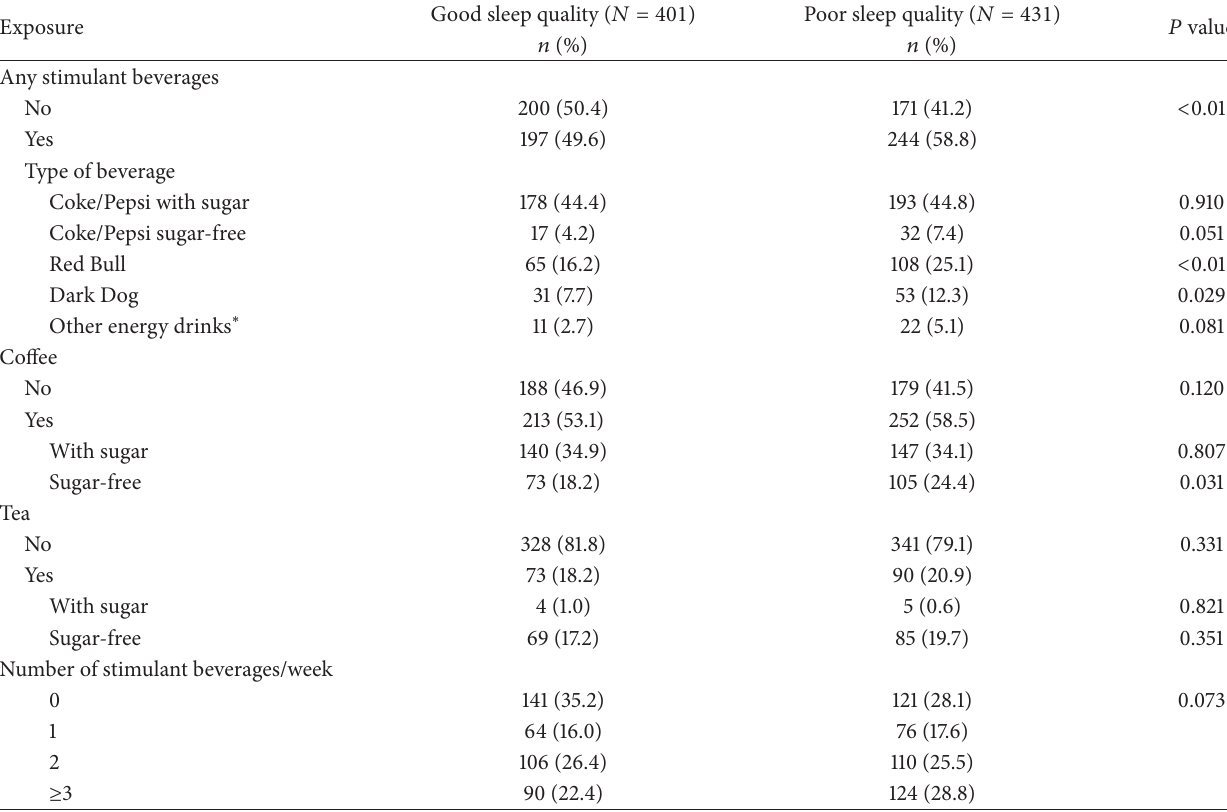
Table 4: Consumption of energy drinks, caffeinated beverages and stimulants in relation to sleep quality status.